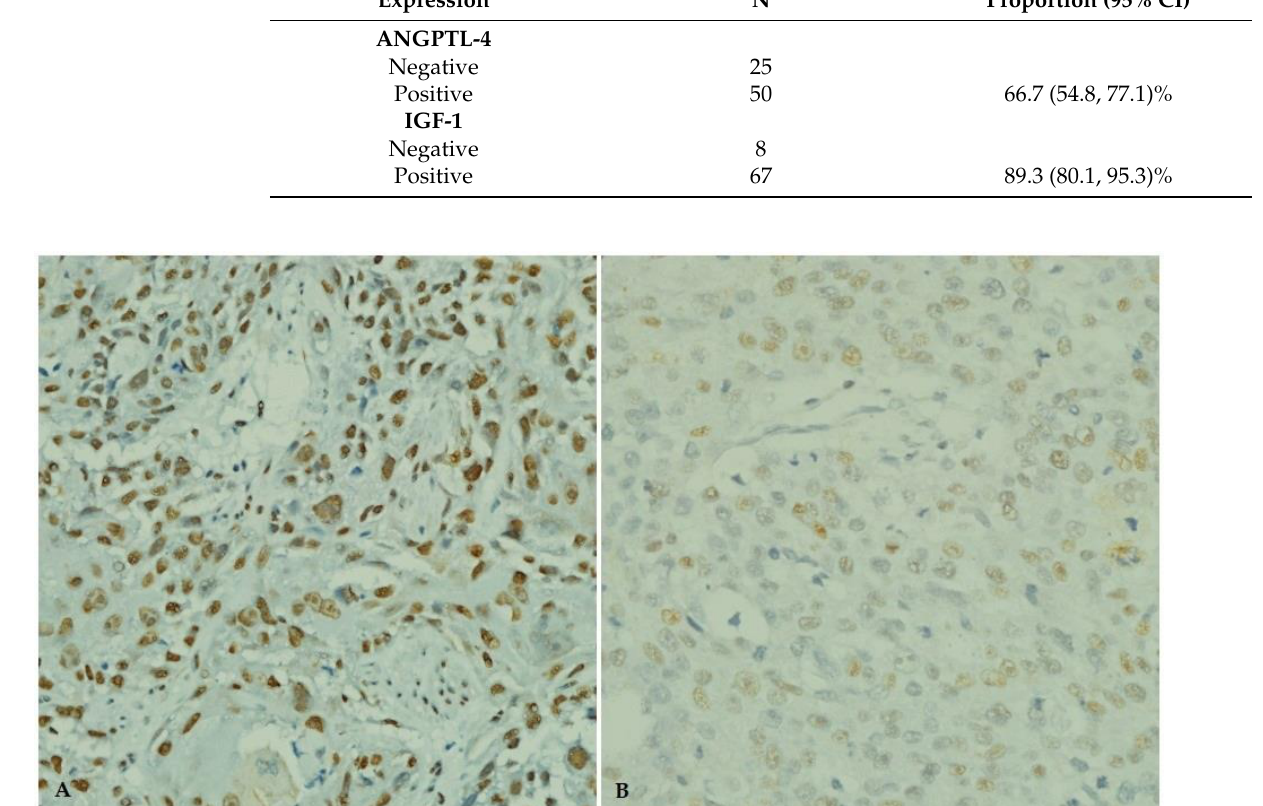
Table 3. Expression of ANGPTL-4 and IGF-1 in young patients with breast cancer ( n = 75). Expression